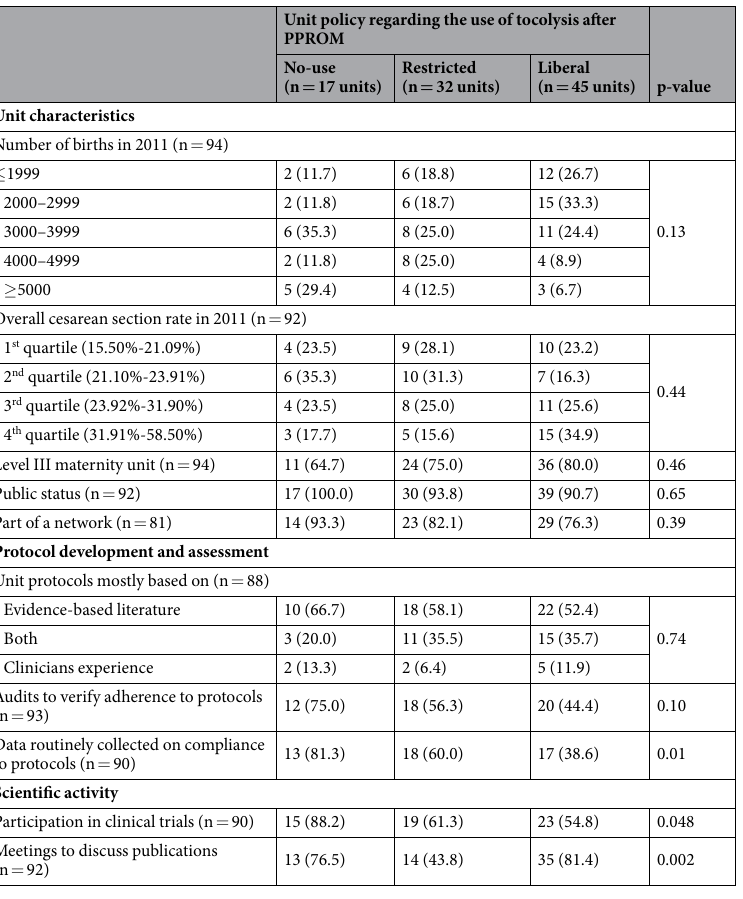
Table 1. Association of unit characteristics and unit policy of tocolysis after PPROM. PPROM: preterm premature rupture of